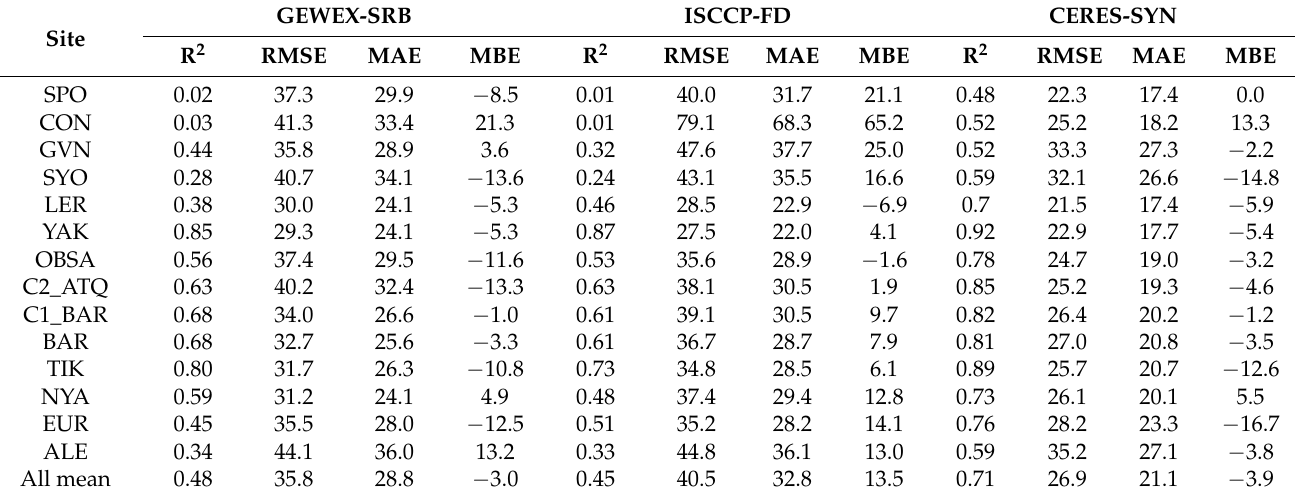
Table 3. R 2 , RMSE, MAE, MBE of DLR between satellite-estimated and ground observed at all stations for 2007. RMSE, MAE, and MBE are in units of W/m 2 . The sites are sorted from high latitudes in Antarctic to high latitudes in